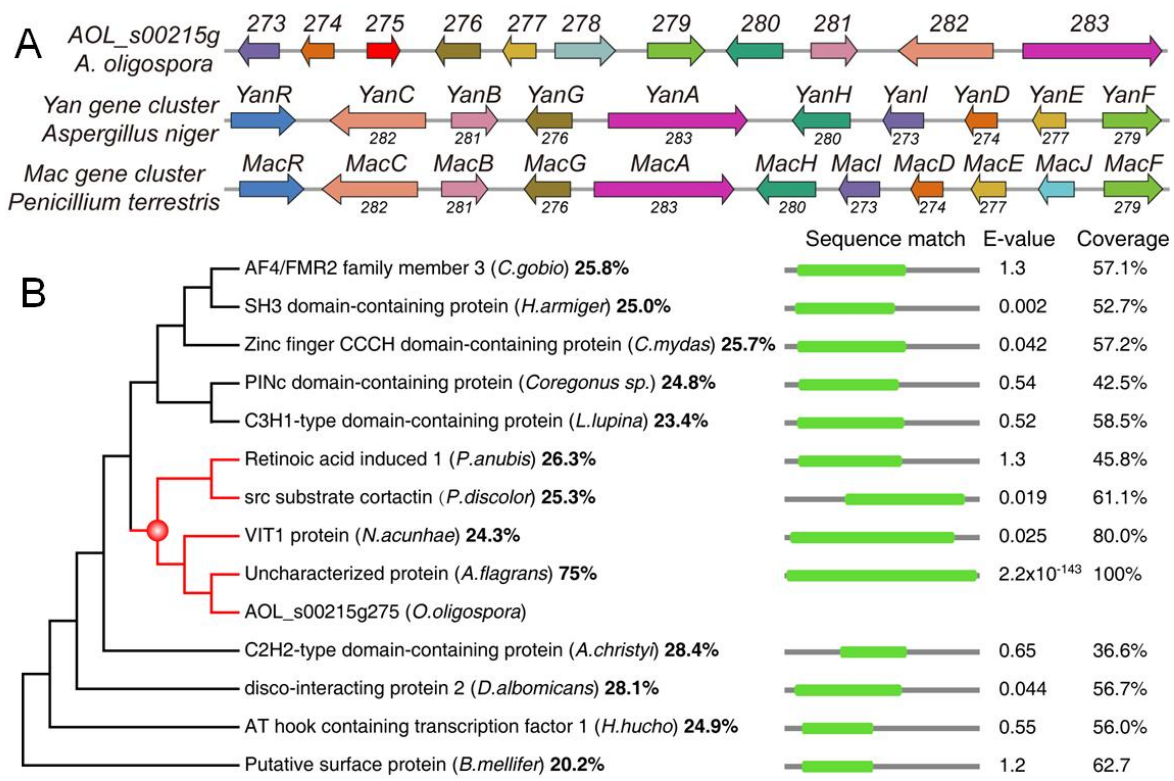
Figure 1. Organization of the genes in the 215g , Yan , and Mac gene clusters for the PKS-PTS hybrid metabolites ( A ), and phylogenetic analysis of 13 sequences with high coverage and similarity to 275 ( B ).